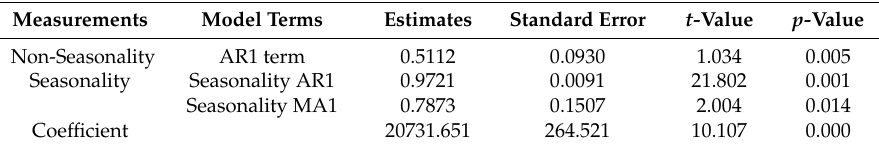
Table 1. Estimates and standard error of SARIMA model parameters.